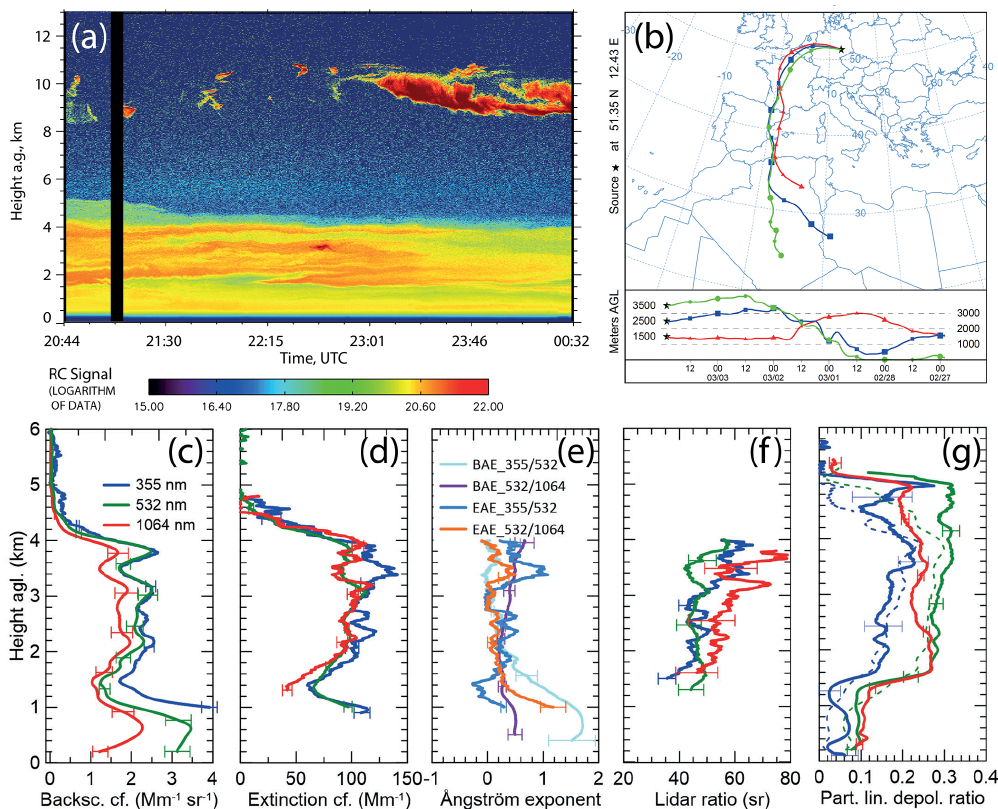
Figure 3. Same as Fig. 1, except for 3–4 March 2021 at 20:44–00:32UTC. (a) Time–height display of the 532nm cross-polarized, range- corrected (RC) signal. (b) HYSPLIT back trajectory for 3 March 2021 at 22:00UTC (please note that the date format in this panel is month/day). (c) Particle backscatter coefficient (200m vertical smoothing). (d) Particle extinction coefficient (750m vertical smoothing). (e) Extinction Ångström exponent (EAE, 750m vertical smoothing) and backscatter Ångström exponent (BAE, 200m vertical smoothing) for the given wavelengths pairs. (f) Lidar ratio (750m vertical smoothing). (g) Particle linear depolarization ratio (PLDR, 200m vertical smooth- ing). All shown optical properties are the mean profiles from 21:11–00:32UTC, except the thick lines of the PLDR (20:44–21:04UTC). The dashed lines of the PLDR at 355 and 532nm belong to the main measurement at 21:11–00:32UTC, where the dust layer height